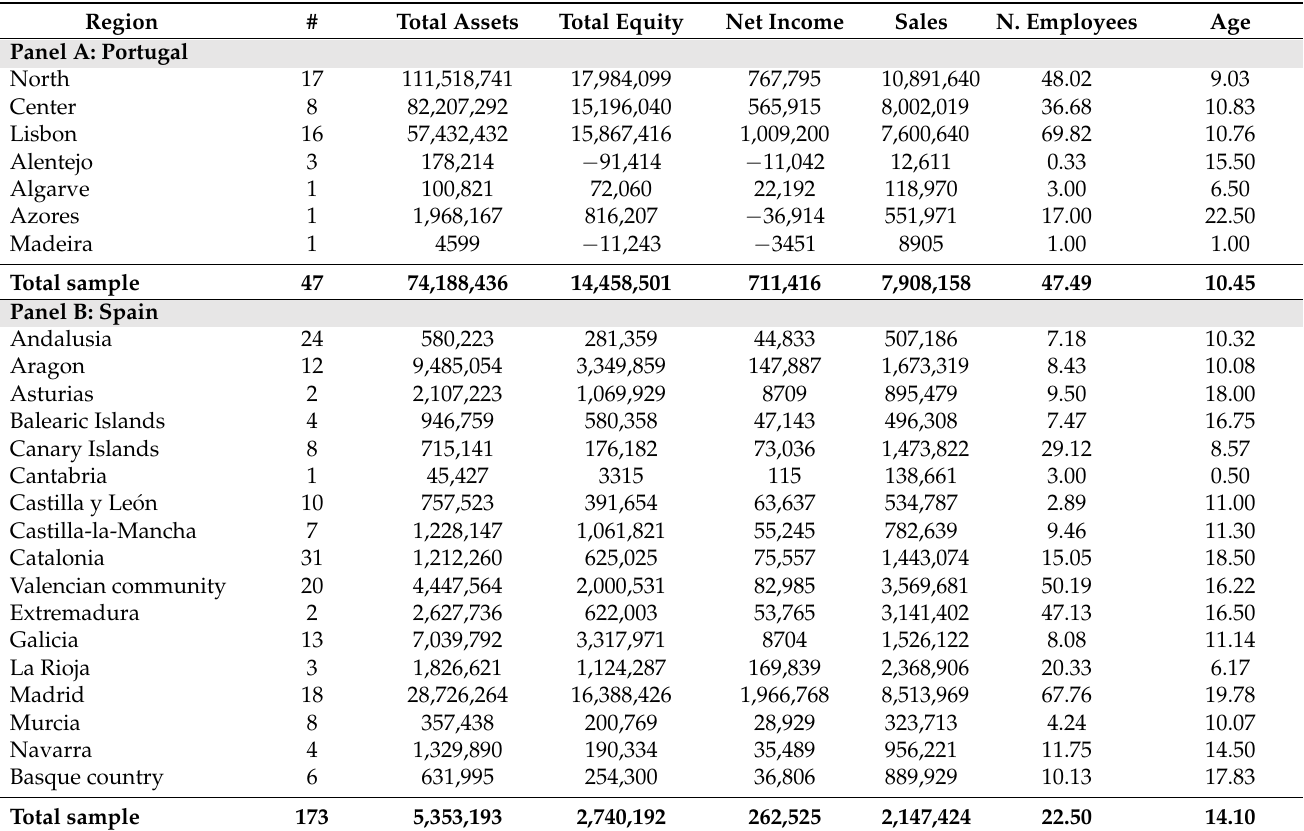
Table 2. Mean values of main accounting information (annual data) per region.